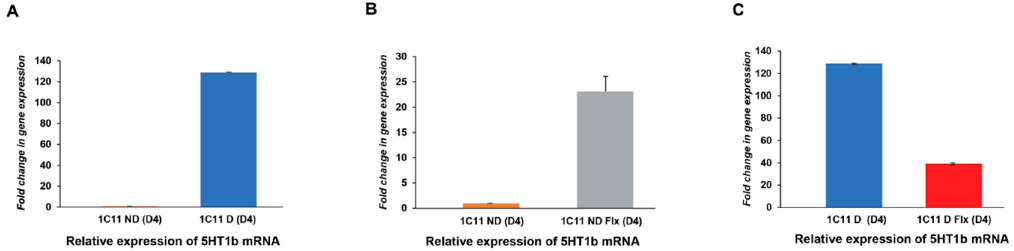
Figure3. Fluoxetinee ff ecton5HT1bmRNAlevelsinthe1C11celllineduringculture. The5HT1bmRNA level is determined by qRT-PCR. ( A ) Real time PCR analysis confirms the high expression of